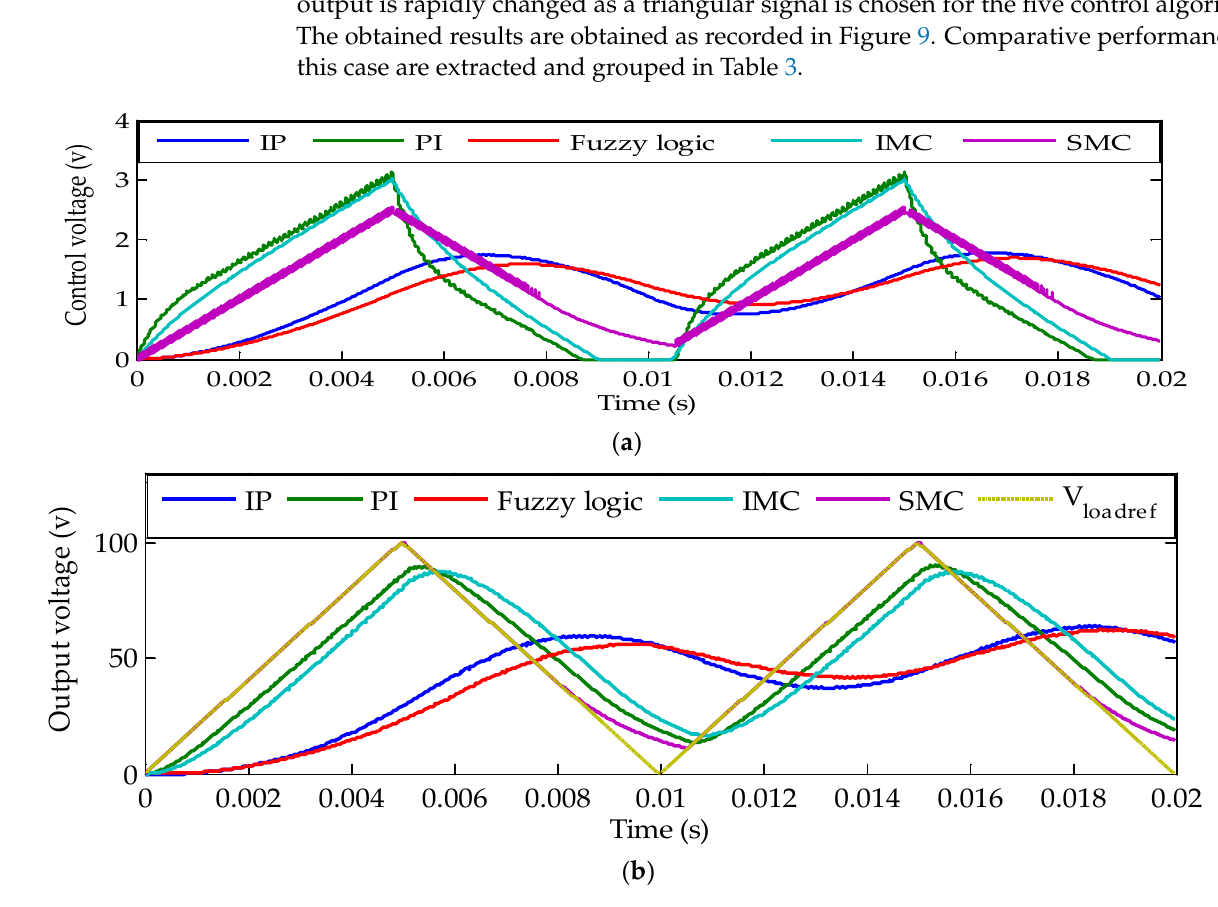
Figure 9. Triangular target output voltage variation: ( a ) evolution of the control voltage and ( b ) evolution of the output voltages.